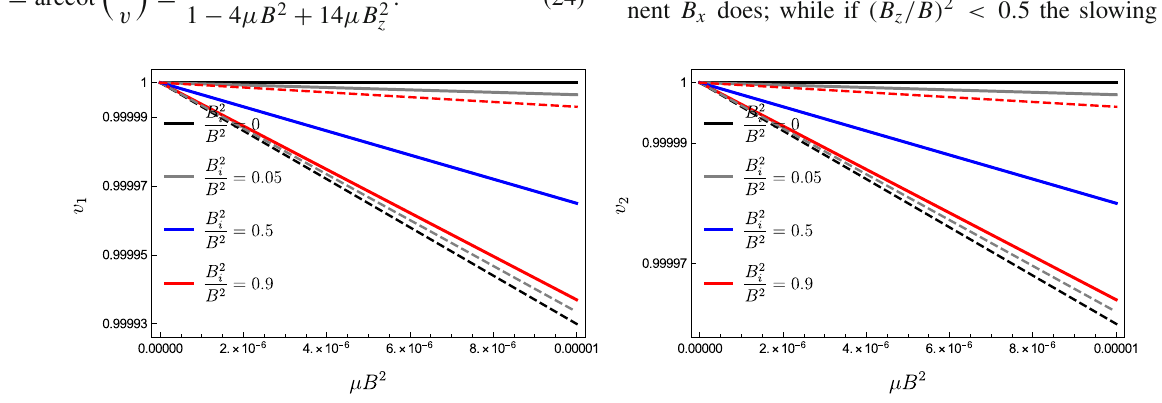
Fig. 2 The phase velocities v 1 ,v 2 are shown as a function of the (dimensionless) magnetic background μ B 2 , for four values of ( B x / B ) 2 (thick lines) and ( B z / B ) 2 (dashed lines). As μ B 2 increases v 1 , 2 dimin- ish. If μ B 2 = 0 the velocity is the one in vacuum, v i = c = 1. Note that if ( B x / B ) 2 < 0 . 5 the slowing effect increases as the